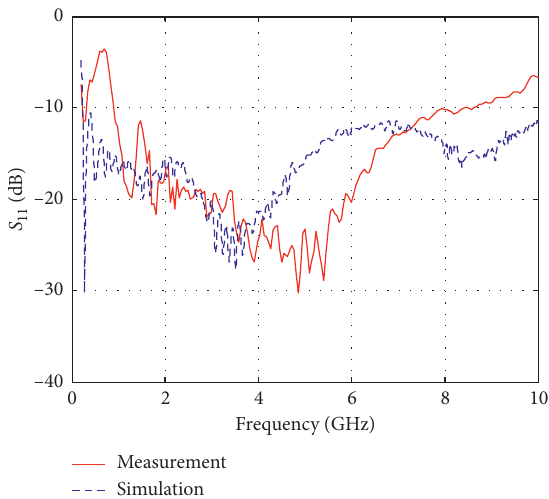
Figure 20: Measured and simulated reflection coefficient S